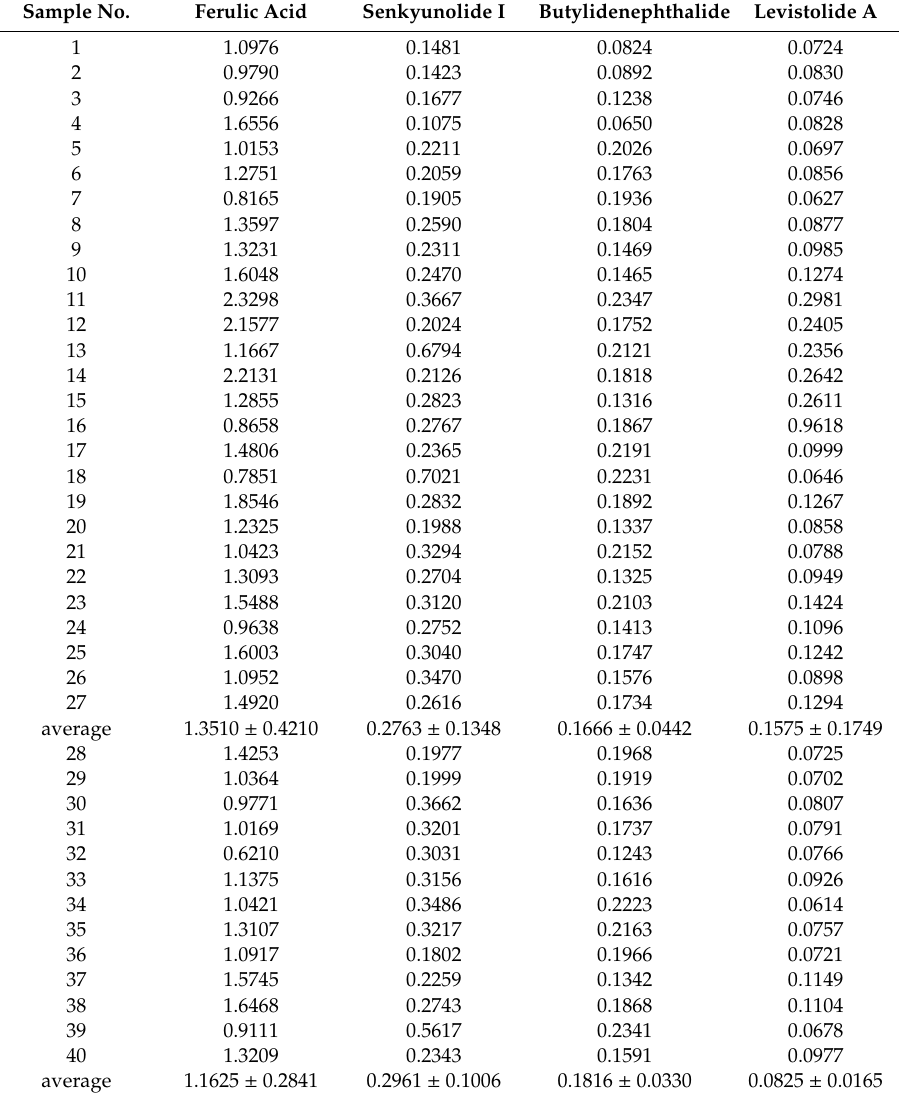
Table 3. The contents of four compounds in RAS (mg /